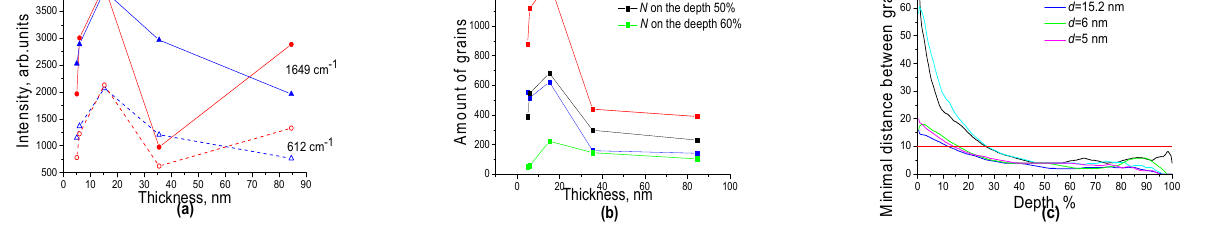
Figure 5. Comparison of the Raman efficiency and features of the SERS substrate structure. ( a ) De- pendencies of the SERS intensity at a Rh6G concentration of 10 − 7 M for the 612 cm − 1 and 1649 cm − 1 bands on the nanostructure thickness. ( b ) Dependencies of amount of grains N on the nanostructure thickness at the different depth. ( c ) Dependencies of average minimal distance between grains on the depth for each area of the specified thickness.